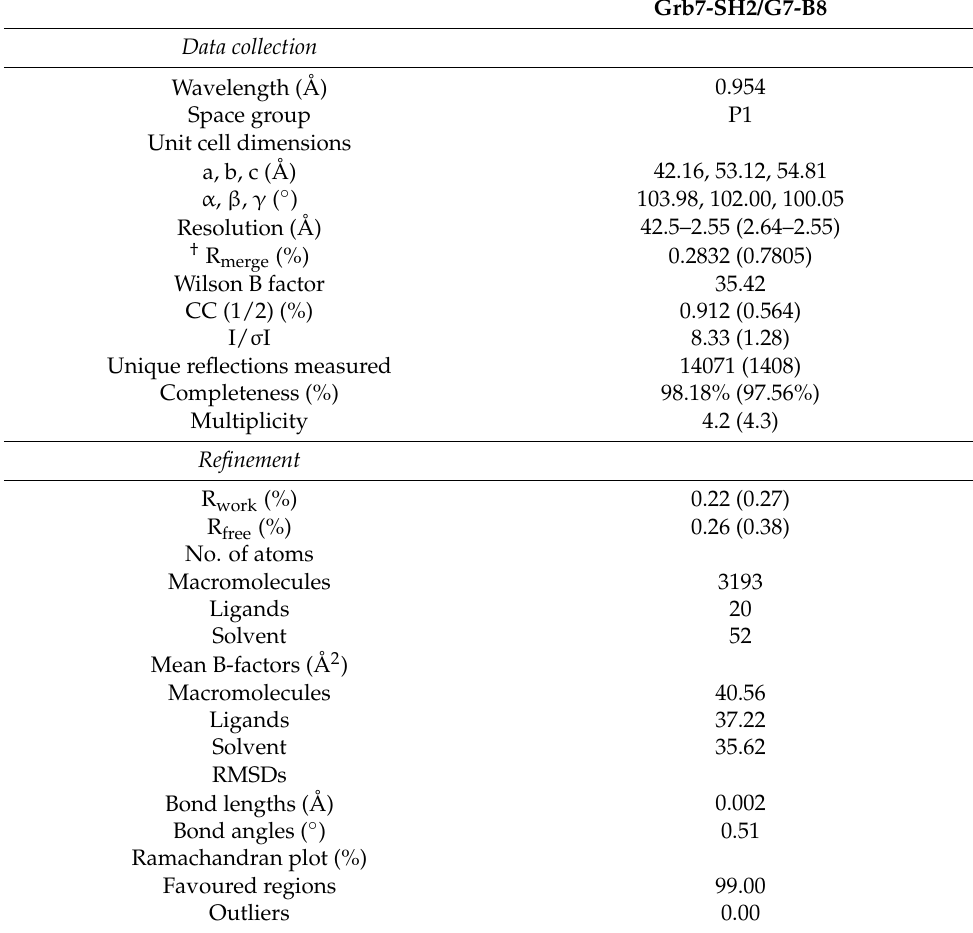
Table 1. X-ray data